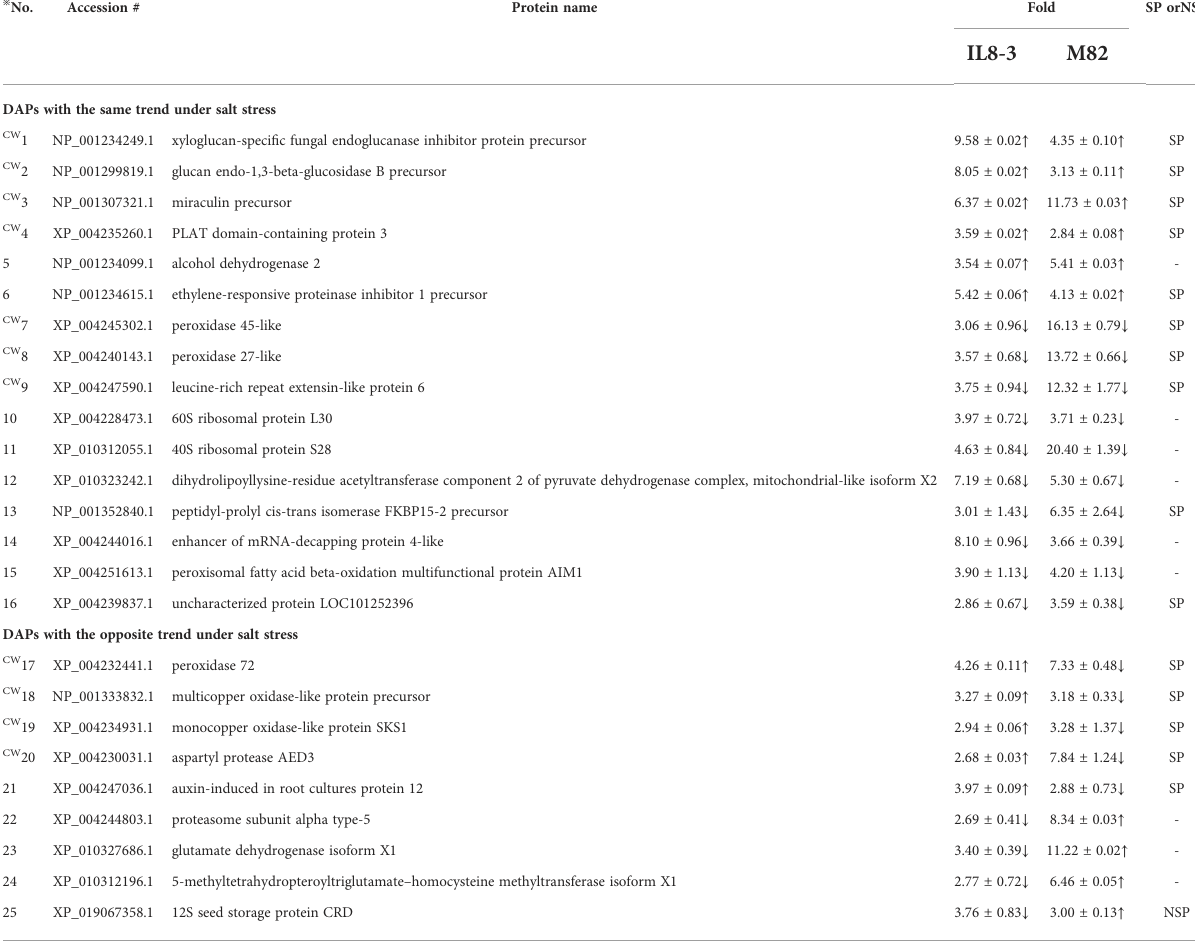
※ Cell wall related protein labeled CW before the No. Fold changes with up arrow (" ↑ ") behind and with down arrow (" ↓ ") behind represent the increased and decreased in protein abundance in response to salt stress, respectively. SP refers to the presence of a signal peptide sequence predicted by SignalP (version 4.0). NSP indicates nonclassical secretory proteins predicted by SecretomeP server 2.0 with an NN score >